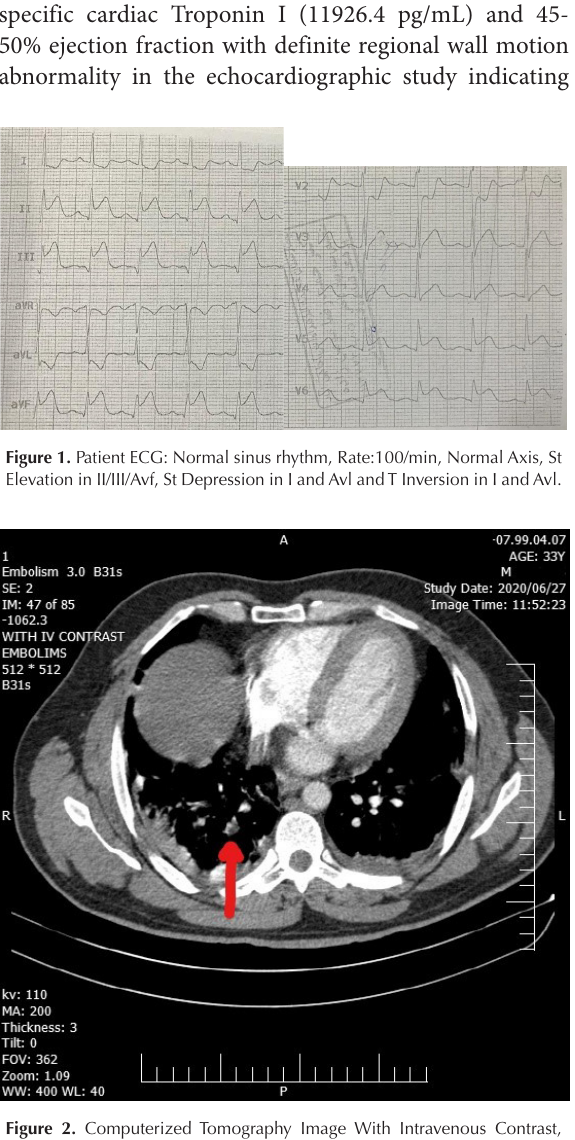
Figure 2. Computerized Tomography Image With Intravenous Contrast, Suggesting Pulmonary Thromboembolism.